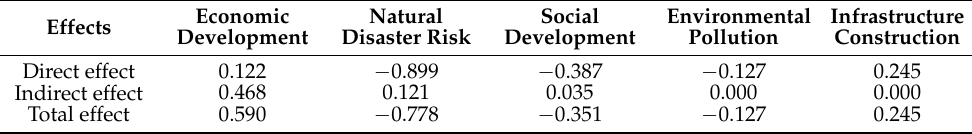
Table 6. The effects of the five subsystems on ecological resilience in the